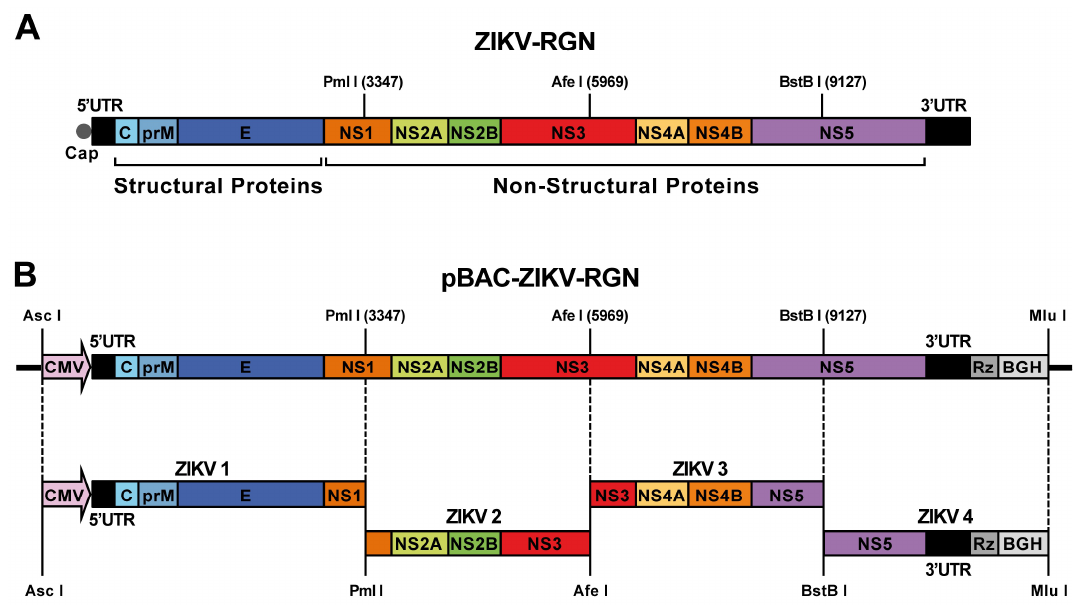
Figure 1. Assembly of a Zika Virus-Rio Grande do Norte Natal (ZIKV-RGN) infectious cDNA clone as a bacterial artificial chromosome (BAC). ( A ) Genetic structure of the ZIKV-RGN strain genome. The coding region from the structural (C, prM and E) and NS (NS1, NS2A, NS2B, NS3, NS4A, NS4B and NS5) proteins are illustrated by colored boxes. Relevant unique restriction sites in the viral genome used for the assembly of the infectious clone and their genomic positions (in brackets) are indicated. 5’ and 3’ UTR: 5’ and 3’ untranslated regions; cap: cap structure. ( B ) Strategy to assemble the ZIKV-RGN infectious cDNA clone. Four overlapping DNA fragments (ZIKV 1 to ZIKV 4, left to right), covering the entire viral genome and flanked by the indicated restriction sites, were generated by chemical synthesis and sequentially cloned into the BAC plasmid pBeloBAC11 to generate the infectious BAC clone pBAC-ZIKV-RGN. The full-length cDNA was assembled under the control of the cytomegalovirus (CMV) immediate-early promoter and flanked at the 3’-end by the hepatitis delta virus (HDV) ribozyme (Rz) followed by the bovine growth hormone (BGH) termination and polyadenylation sequences. Acronyms for coding regions and regulatory elements are as described in panel A.